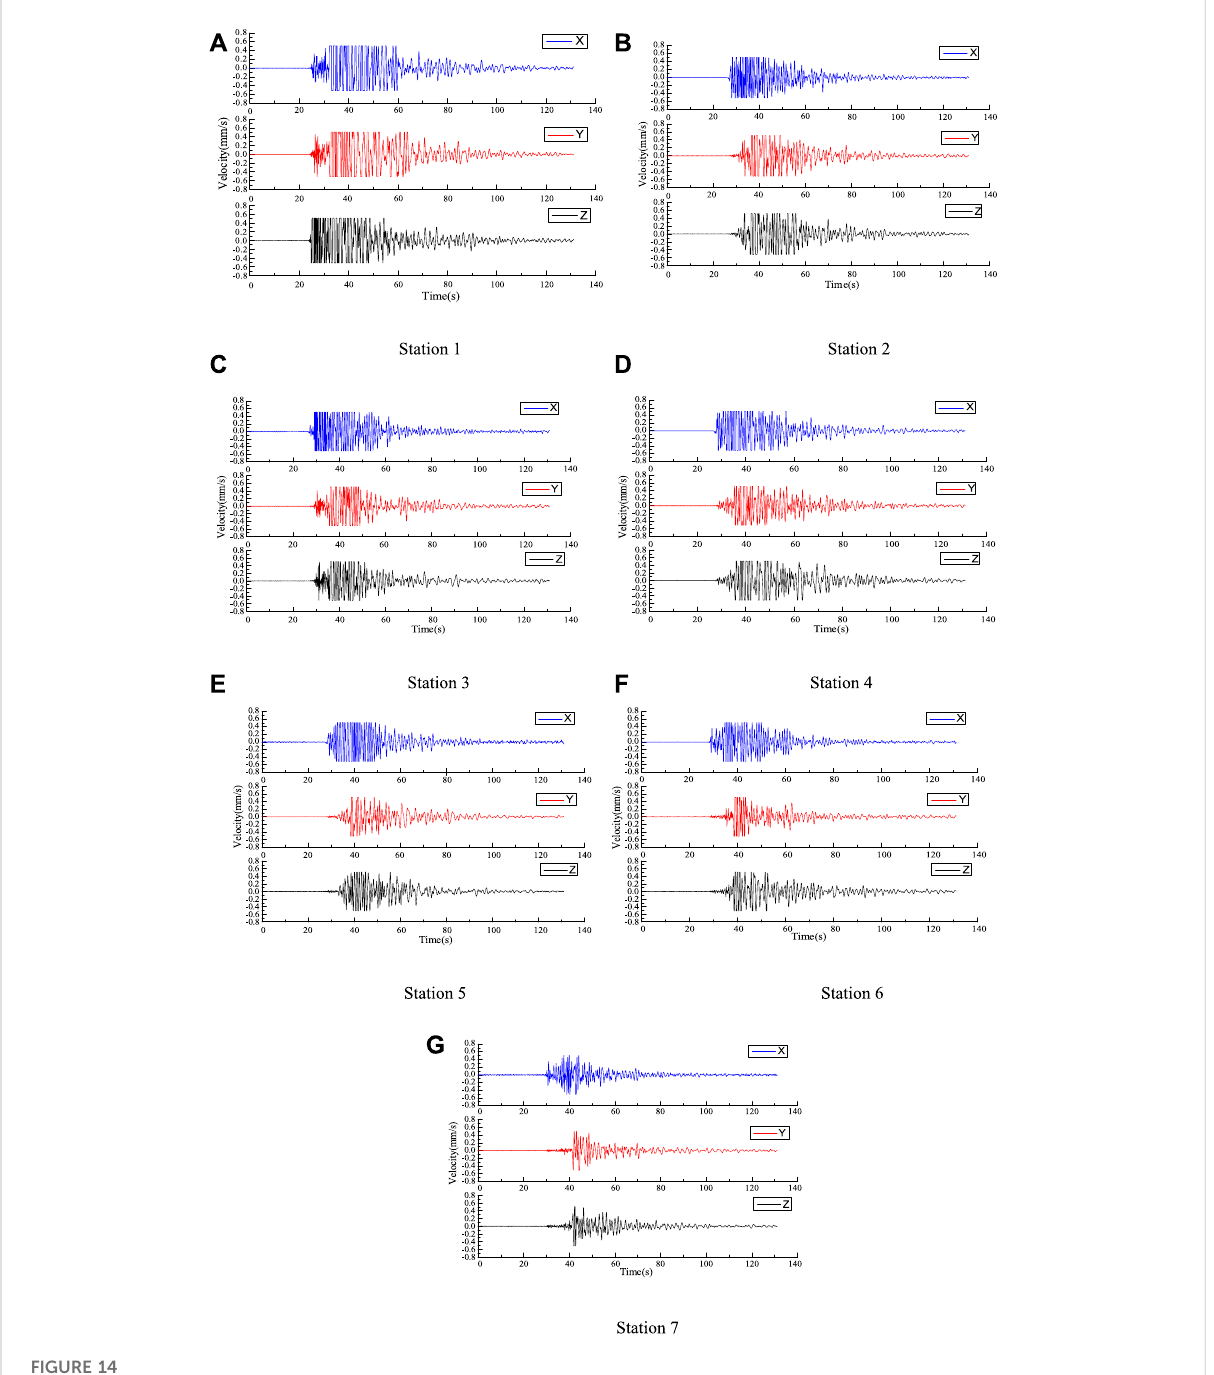
FIGURE 14 Three-component velocity pro fi les for each station for microseismic